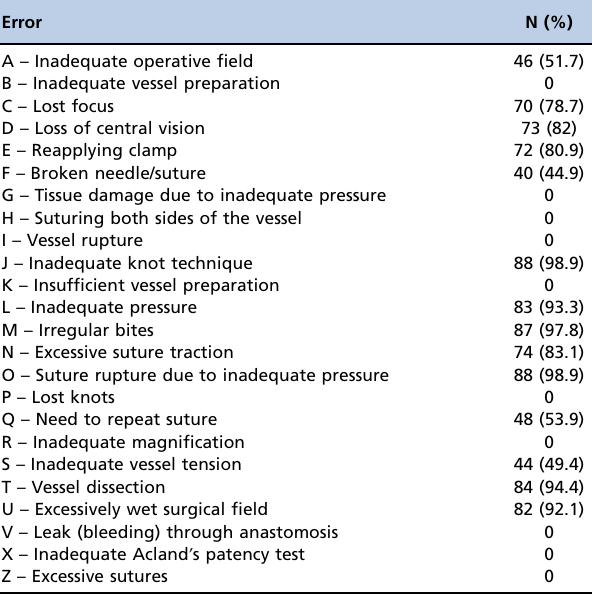
Figure 5 - Learning curve across tasks. Despite the increasing difficulty of the tasks, the increasing scores ( p o 0.05) indicate that this is an adequate training sequence. Table 2 - List of